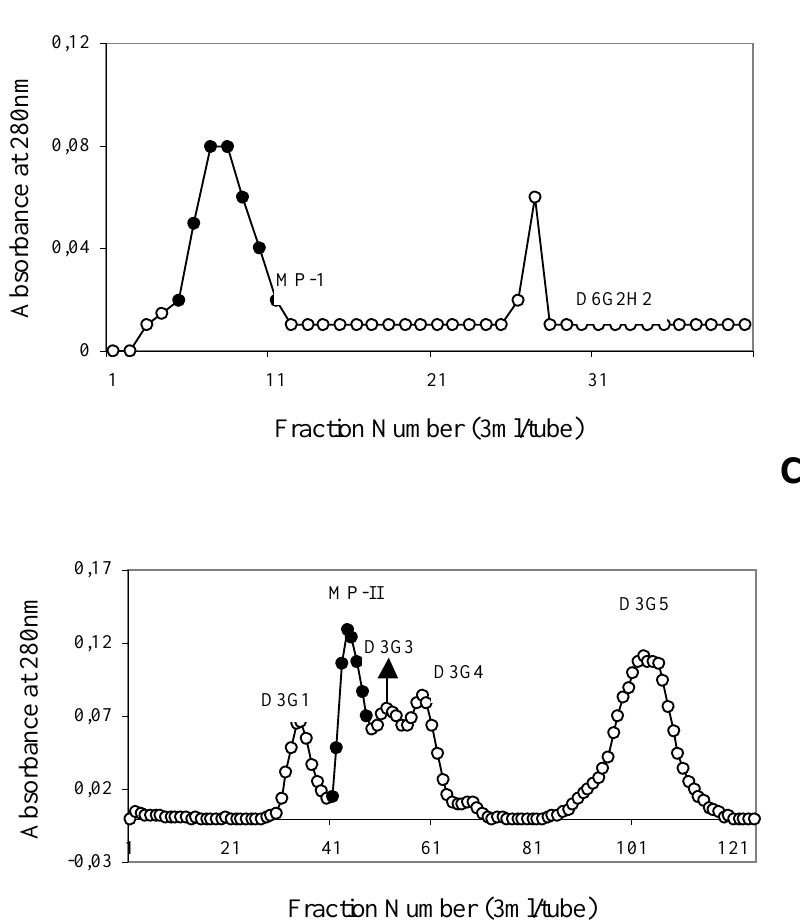
Figure 1. Purification of BaltMP-I and II from Bothrops alternatus venom. (A): Fractionation on DEAE-Sephacel: crude venom (200mg) was applied to the column (1.7X15cm) and elution was carried out at a flow rate of 20ml/h with convex ammonium bicarbonate gradient from 50mM to 1M, pH 7.8. (B): Fractionation on Sephadex G-75: the active fraction (D6) was applied to the column (2X100cm) and elution with 50mM ammonium bicarbonate buffer at pH 7.8 was achieved at a flow rate of 20ml/h. (C): Fractionation on Heparin-Agarose: the enzyme concentrate (D6G2) was applied to the column (1.7X15cm) and elution was carried out at a flow rate of 40ml/h with 10mM Tris-HCl buffer containing 1M NaCl at pH 7.0. The isolated enzyme was named BaltMP-I. (D): Fractionation on Sephadex G-75: the active fraction (D3) was applied to the column (2X100cm) and elution with 50mM ammonium bicarbonate buffer at pH 7.8 was achieved at a flow rate of 20ml/h. The isolated enzyme was named BaltMP-II. Protein was monitored by absorbance at 280nm. Fractions pooled are indicated by the closed